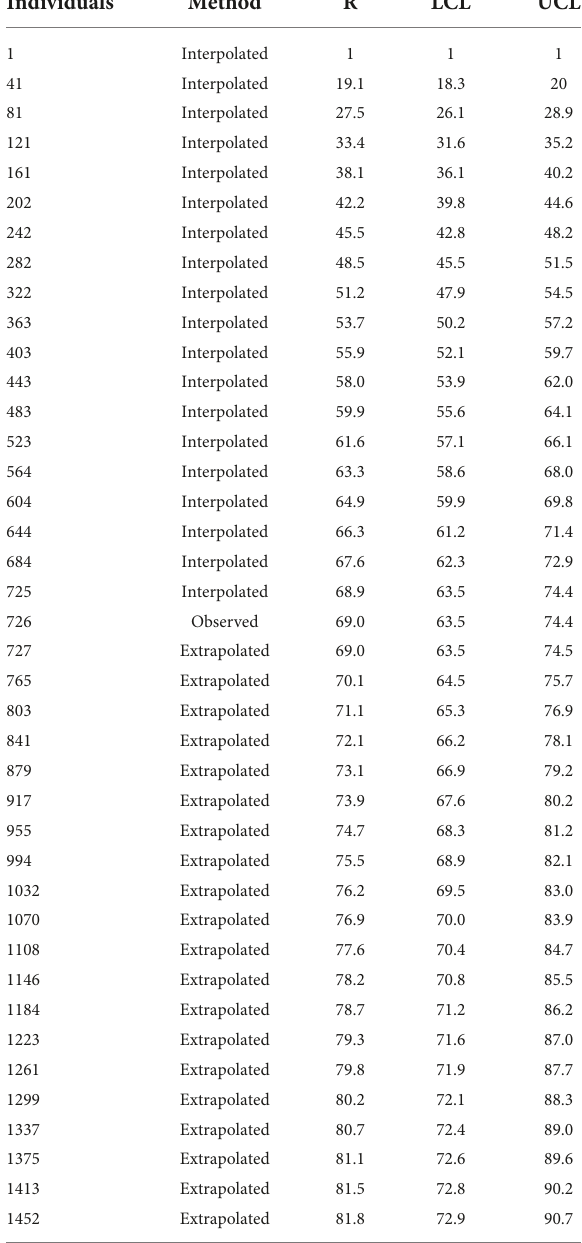
TABLE 2 Estimated richness of bird species that forage across Zacualpan, Colima,